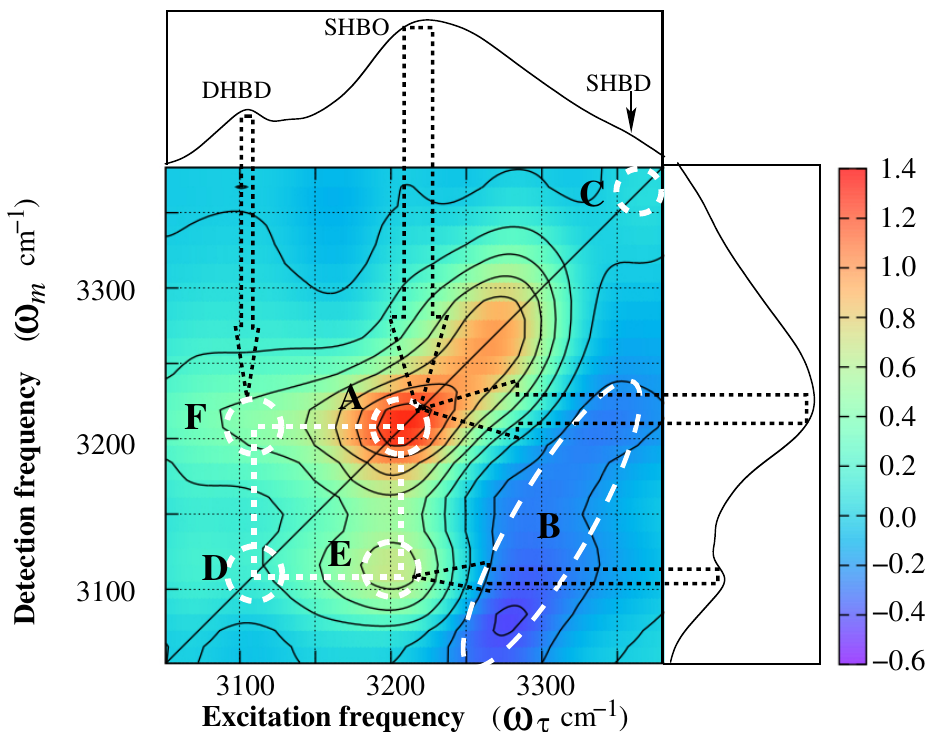
Figure 9. 2DIR photons echo real spectra of 2-Pyrrolidinone at a population time of T w = 600fs. The spectra are collected at the N–H stretch vibrational region and plotted along with 1DIR spectra (FTIR) embedded on the right and top side of 2DIR spectra. The red colour contours are positive-trending and the blue colour contours are negative-trending. The x-axis is the Fourier-transformed τ -axis and the y-axis is the monochromator axis ( ω m axis). Both the linear and two-dimensional spectra are acquired at room